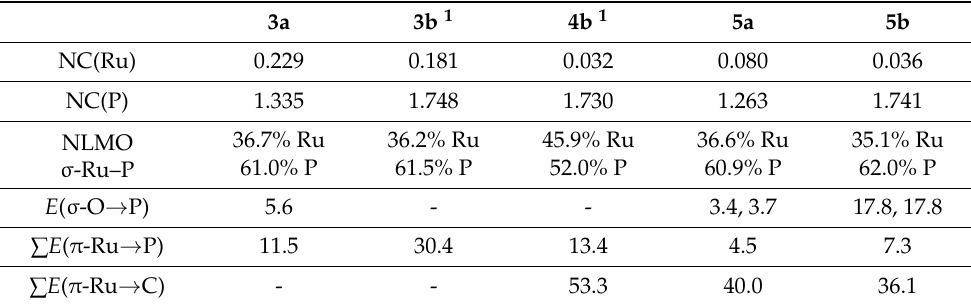
Table 2. Natural charges (NCs) of Ru- and P-atoms and contributions to the NLMO of the Ru–P σ -bonds of compounds 3a , 3b , 4b , 5a and 5b , as well as energy levels of selected intramolecu- lar donor–acceptor interactions (obtained from second-order perturbation theory) in kcal mol − 1 ( ∑ E ( π -Ru → P) = sum of π -back-bonding contributions into relevant σ -antibonding P–O- or P–C- based orbitals ( ∑ E ( π -Ru → C) = sum of π -back-bonding contributions into relevant π -antibonding C–O- or C–N-based orbitals of the CO or CN t Bu